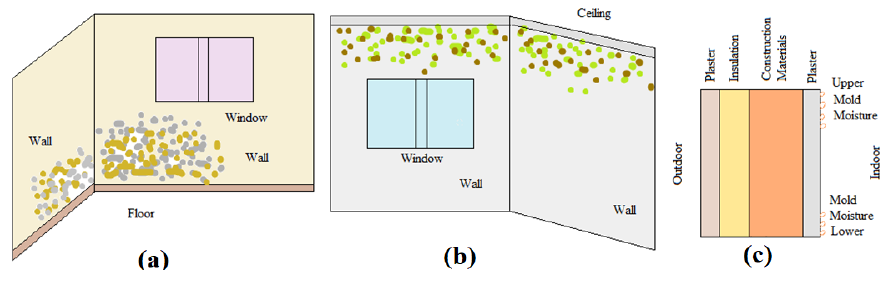
Figure 1. The mold and moisture formation on the wall ( a ), ceiling ( b ), and wall layers ( c